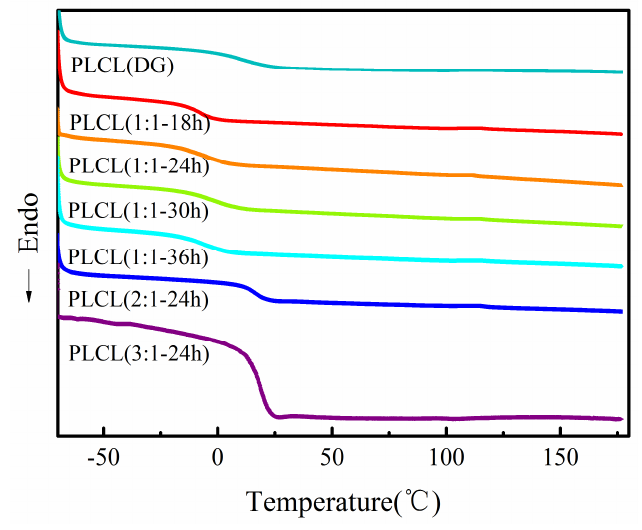
Figure 5. Differential scanning calorimetry (DSC) of PLCL copolymers.